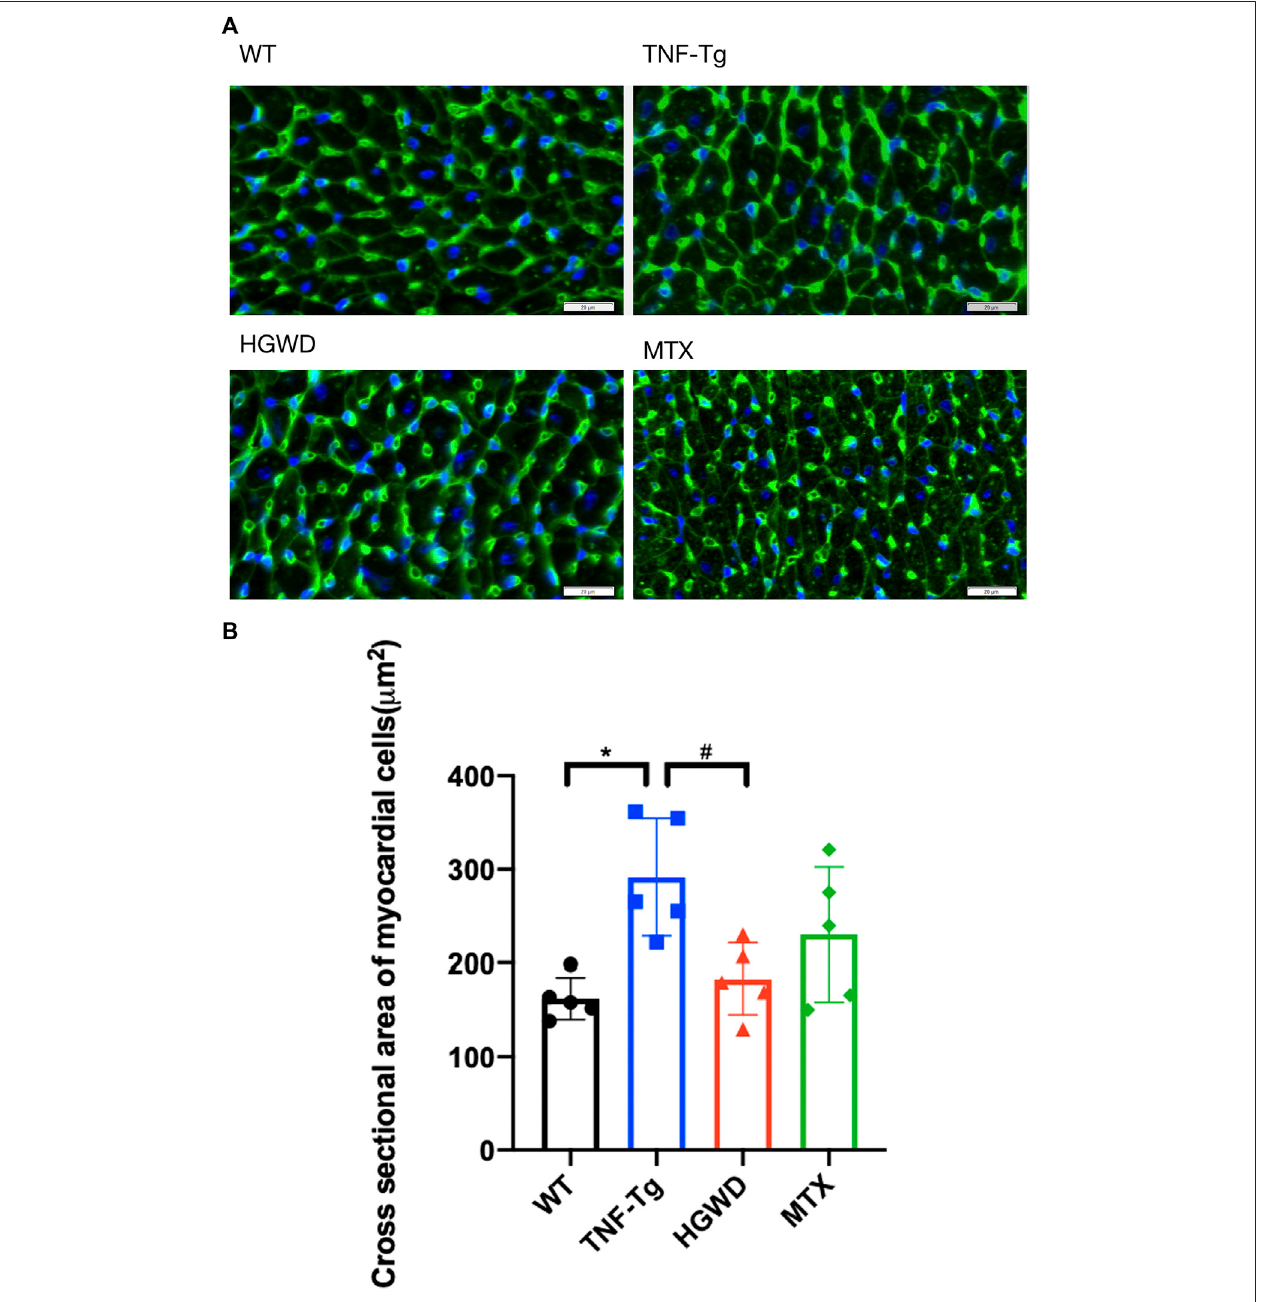
FIGURE3| HGWDalleviatescardiomyocytehypertrophyinTNF-Tgmice. (A) ArepresentativemouseheartWGA-stainedsectionshowedthatthecross-sectional area of cardiomyocytes in TNF-Tg mice increased, and the cross-sectional area after HGWD treatment was smaller than that in the TNF-Tg group. Bar = 20 μ m. (B) Quanti fi cation of the cross-sectional area of cardiomyocytes. Values are the mean plus or minus SD of 5 hearts in each group. * p < 0.05, compared with WT group; # p < 0.05, compared with TNF-Tg group.